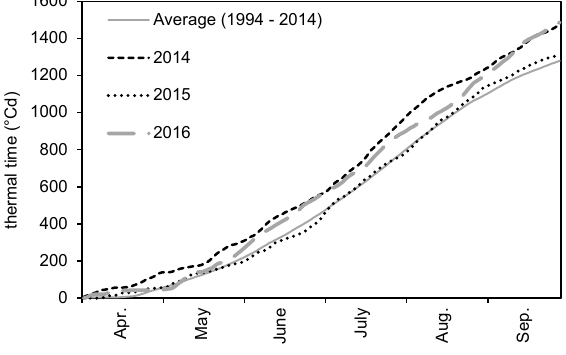
Figure 1: Thermal time according to McMaster and Wilhelm (1997) from April to September at the Hollage experiment. Comparing long average (1994–2014) with 2014, 2015 and 2016 growing seasons